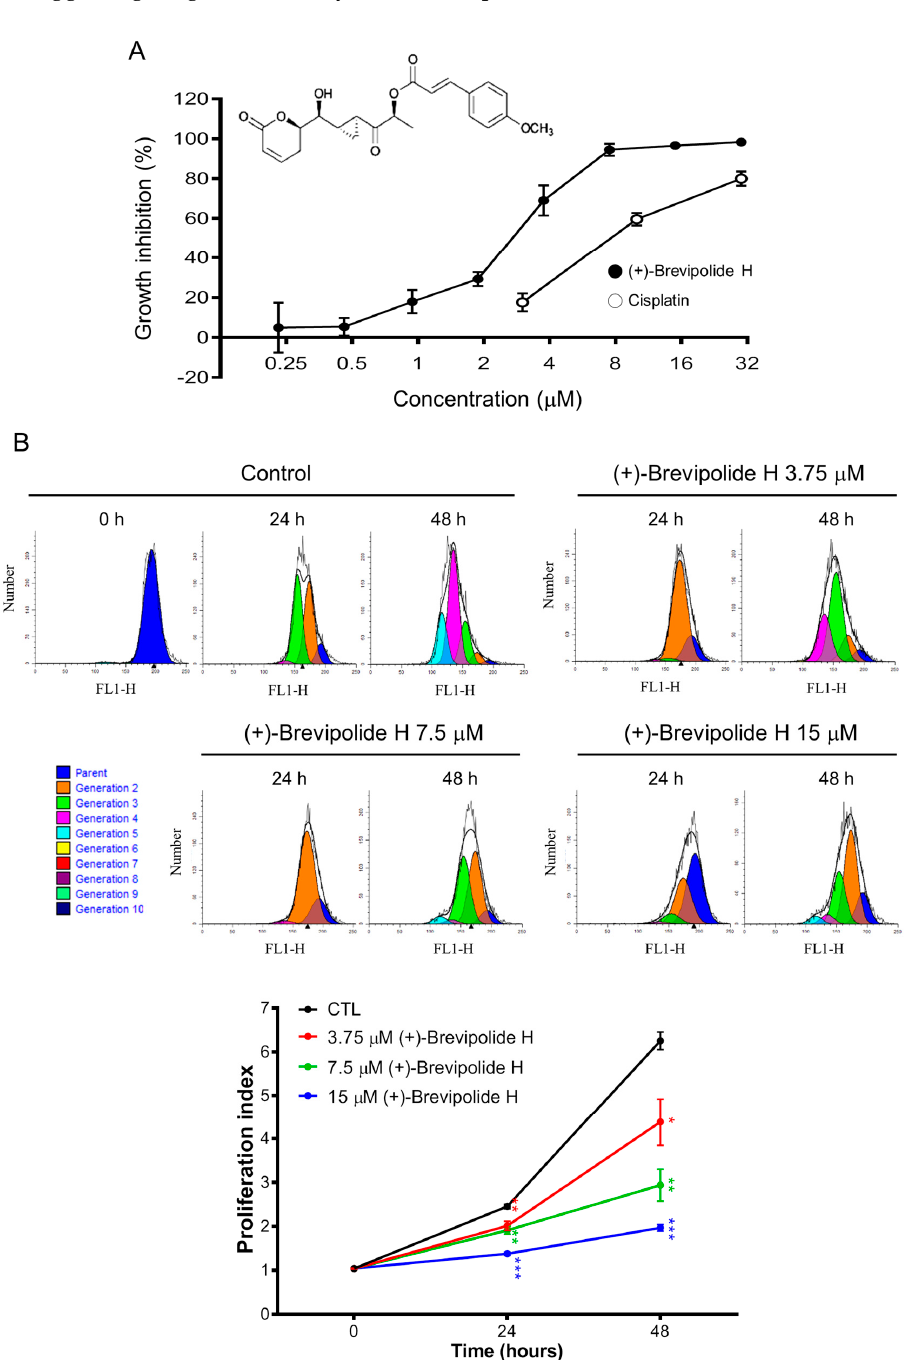
Figure 1. E ff ect of ( + )-brevipolide H on cell proliferation in PC-3 cells. ( A ) PC-3 cells were incubated in the absence or presence of ( + )-brevipolide H for 96 h. After treatment, the cells were fixed and stained for SRB assay. ( B ) The cells were stained with CFSE and incubated in the absence or presence of ( + )-brevipolide H for 24 or 48 h. Cell proliferation was detected using FACScan flow cytometer. Proliferation index was calculated by using ModFit LT TM 3.3 to quantify the inhibition of cell proliferation. Data are expressed as mean ± SEM of three independent experiments; * p < 0.05, ** p < 0.01, and *** p < 0.001 compared with the respective